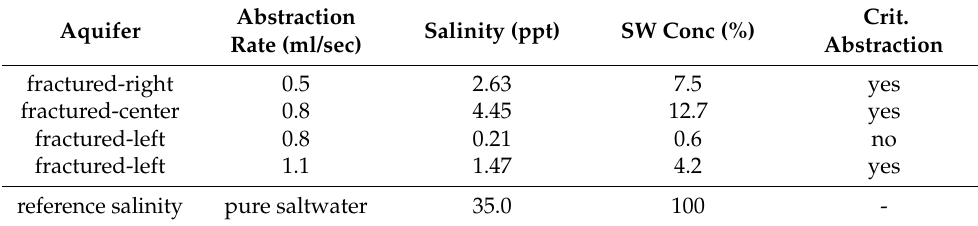
Table 2. Salinity values of water pumped from the three fractured synthetic aquifers, measured with a YSI Professional Plus Instrument (Pro Plus) water quality meter, expressed in parts per thousand (ppt), and as a fraction of the seawater concentration (SW conc), determining if well salinization (Crit. abstraction)